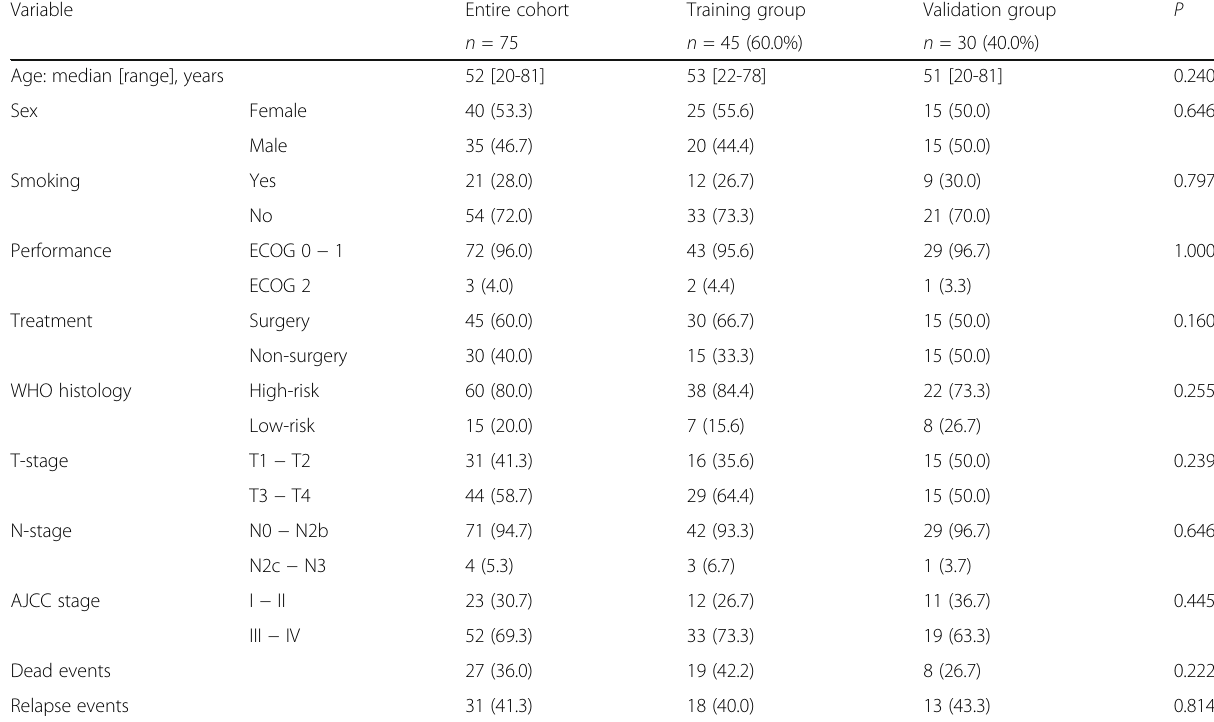
Table 1 General characteristics of the study patients